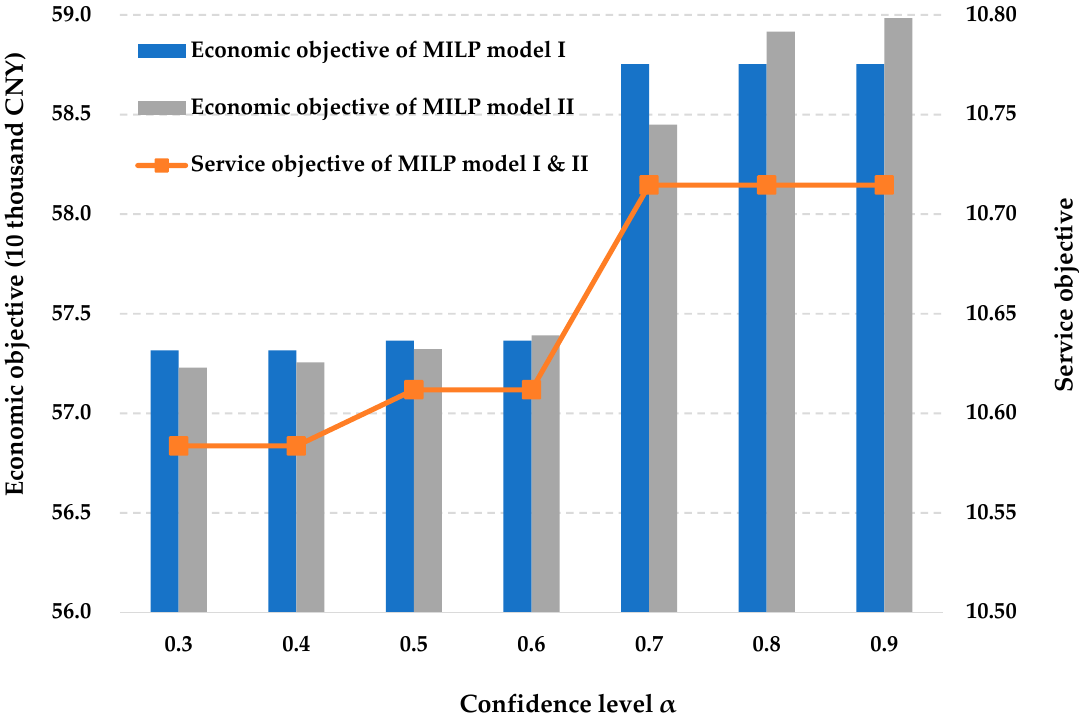
Figure 14. Sensitivity of the routing optimization with respect to the confidence level ( η p = 0.5 and W = 1000).